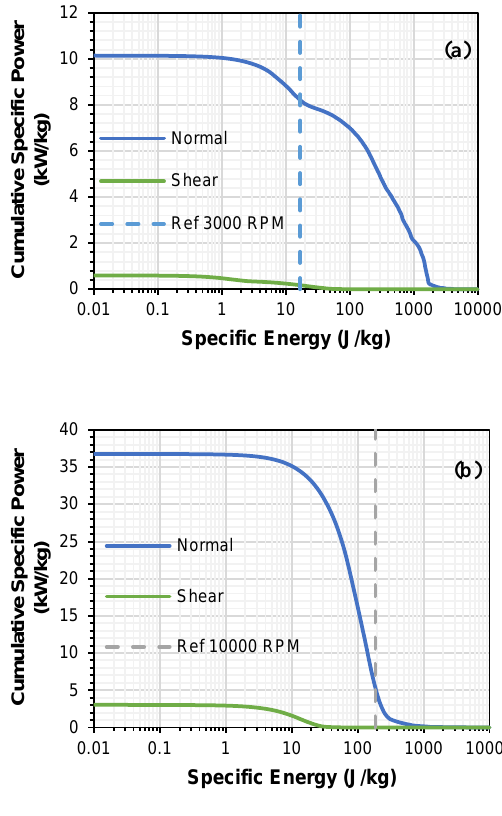
Fig. 7. Particle energy spectra curves of 461 μm particles in a pin mill rotating at (a) 3000 RPM and (b) 10000